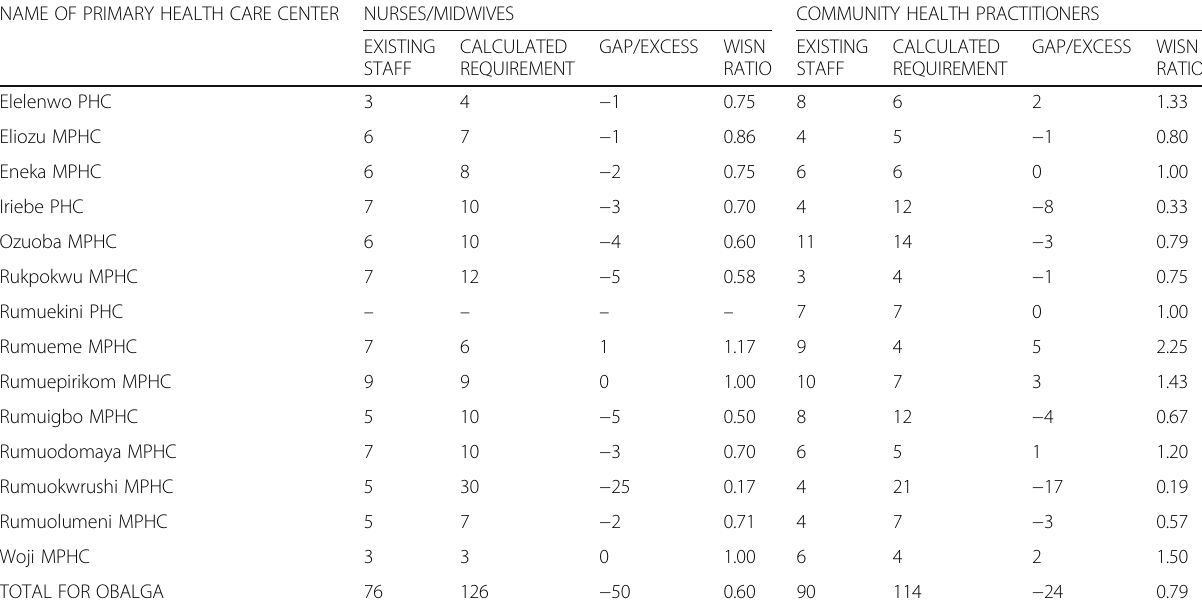
Table 6 Wisn results for nurses/midwives and community health practitioners for Obio akpor local government area (obalga) NAME OF PRIMARY HEALTH CARE CENTER